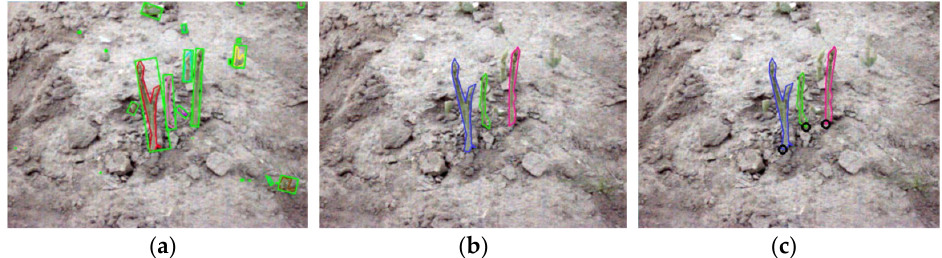
Figure 13. Illustration of the filtering in the cutting experiment: ( a ) All results. ( b ) Filtered results. ( c ) Cutting points of the asparagus.